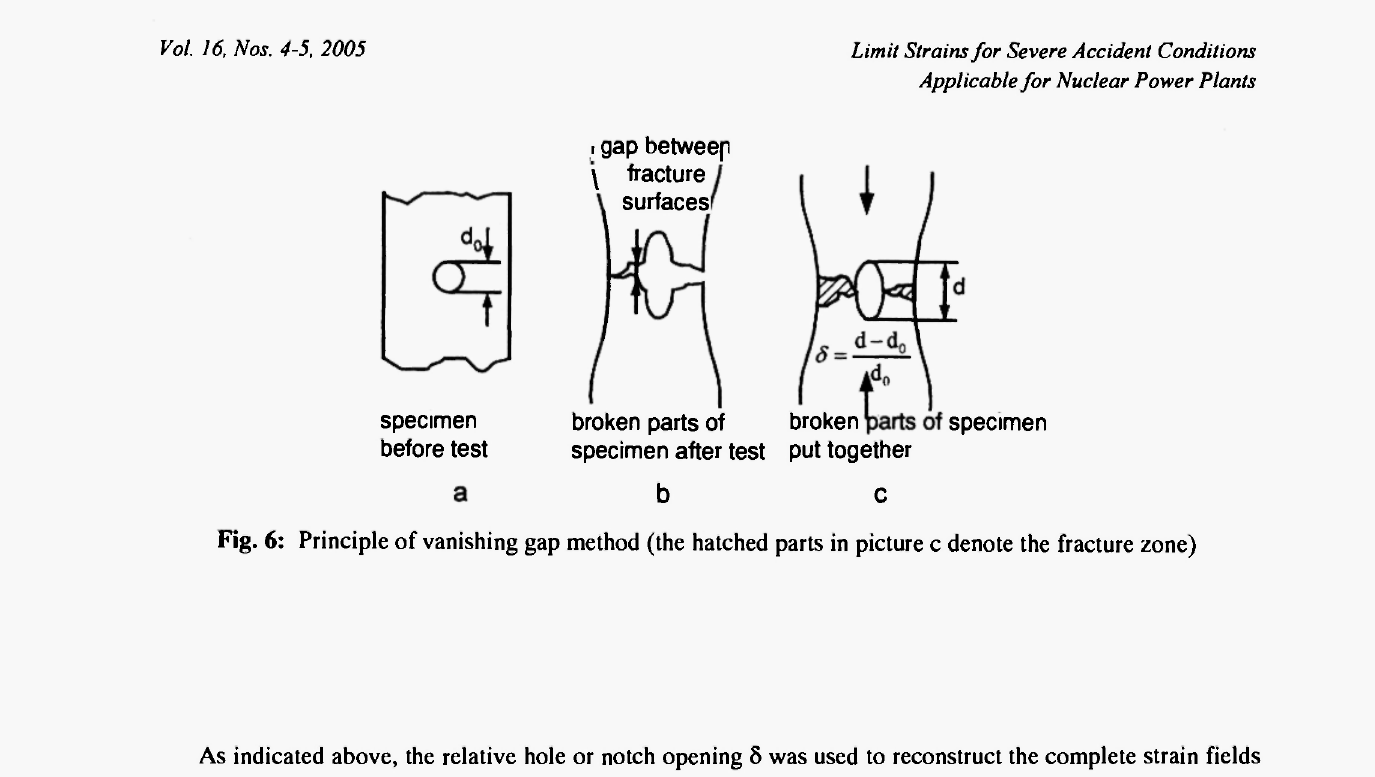
Fig. 6: Principle of vanishing gap method (the hatched parts in picture c denote the fracture zone)